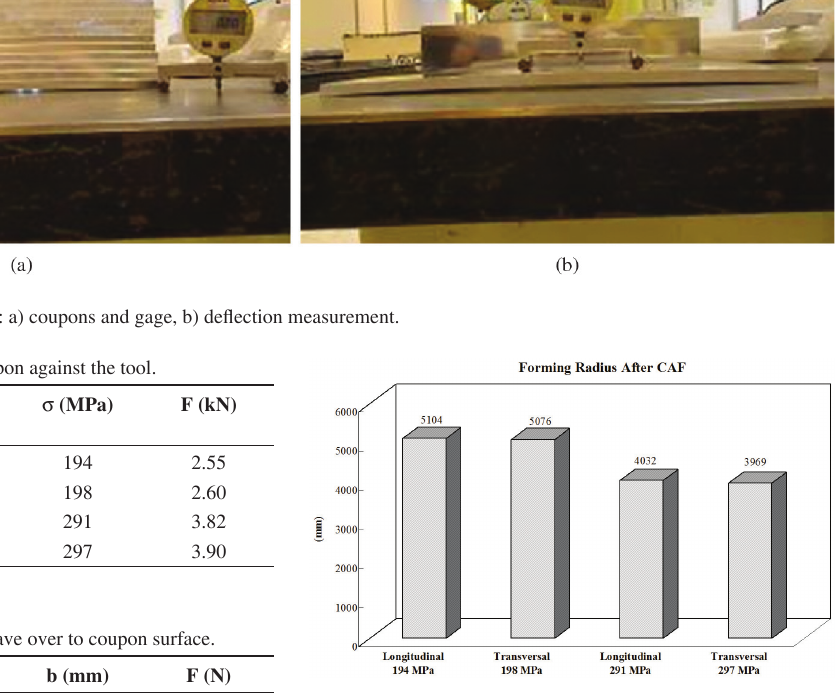
Figure 12. Forming radius after CAF.